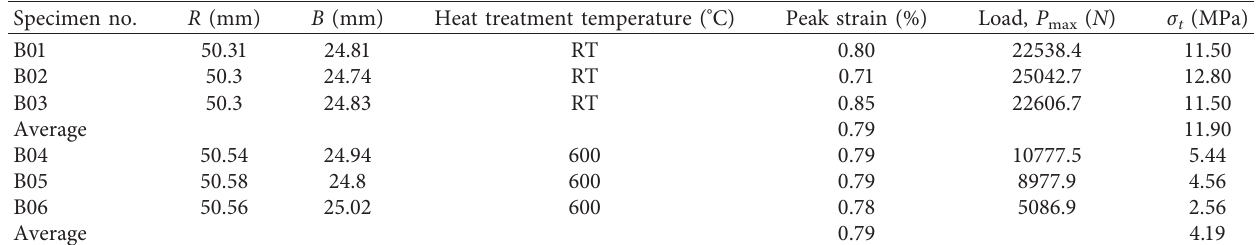
Figure 7: Box diagram of apparent fracture toughness for granite samples untreatment and after high-temperature treatment. Table 4: The Brazilian splitting test